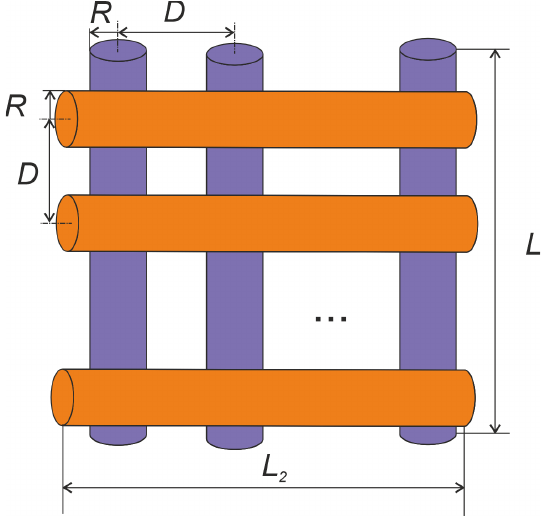
Figure 7. Geometric design variables ( L , L 2 ) and fixed parameters ( R , D ) of the shielding structure.